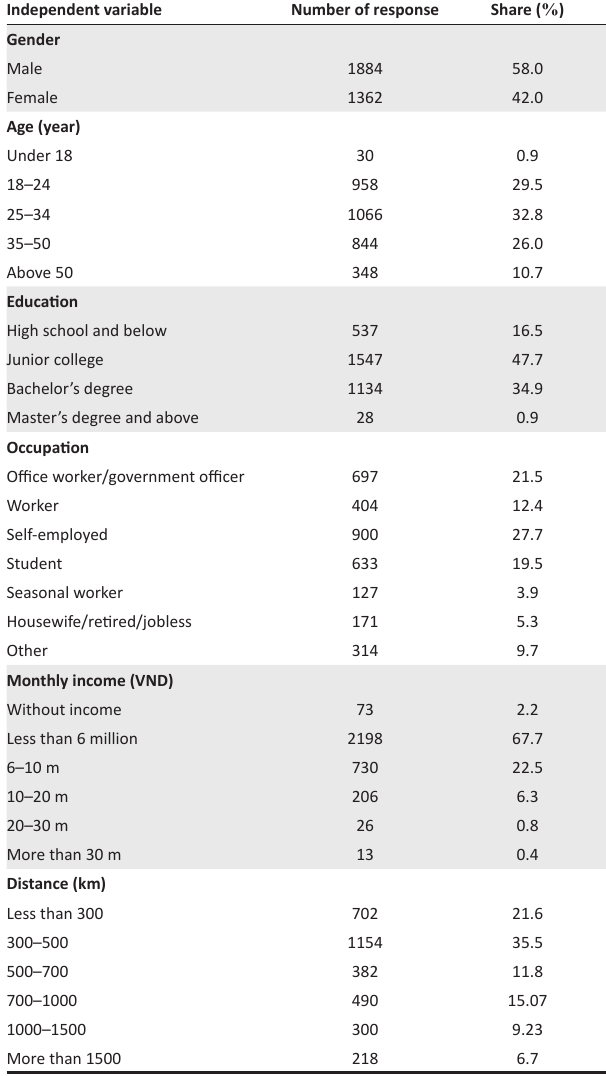
TABLE 3: Summary statistics of